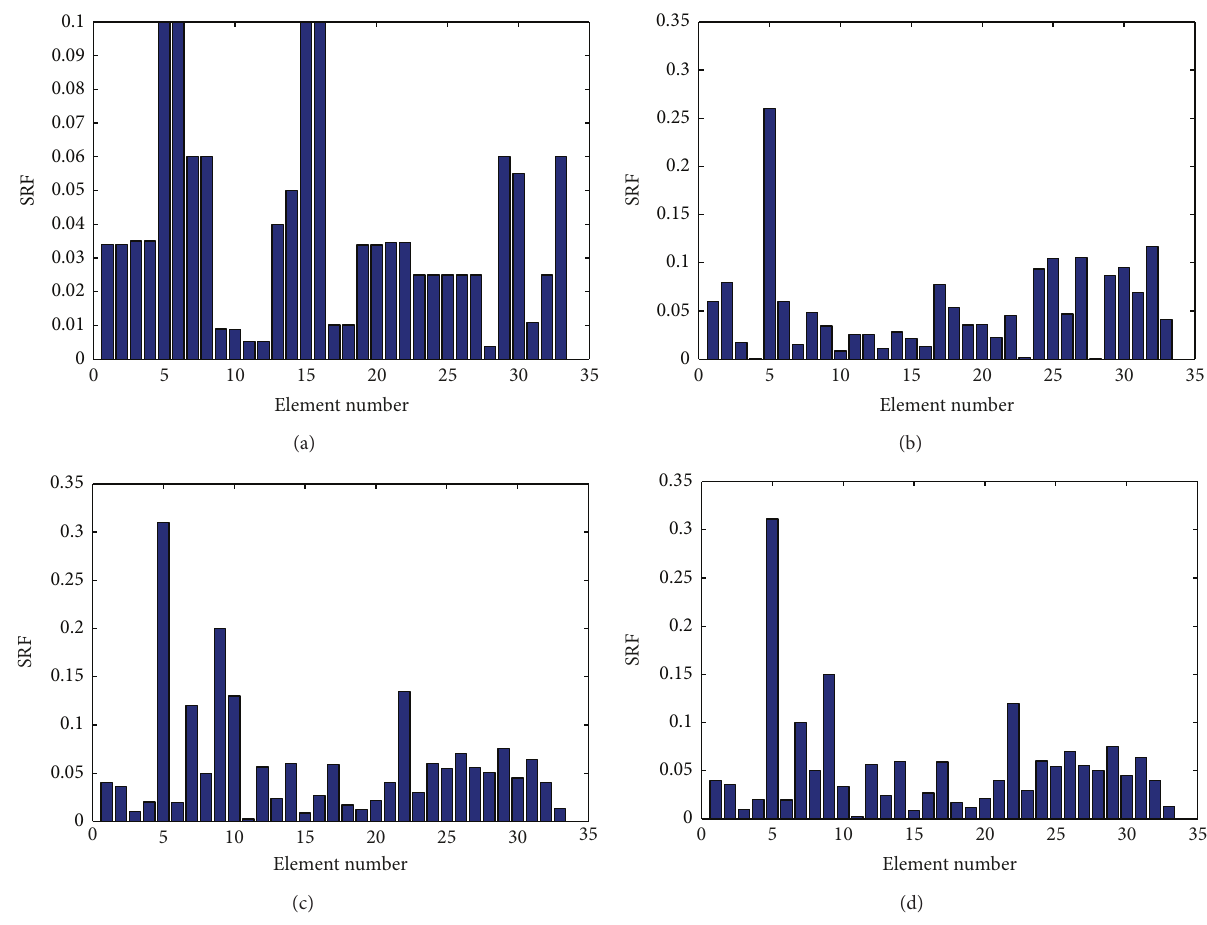
Figure 6: SRF values of substructure sensitivity method (iterations 1, 3, 4, and